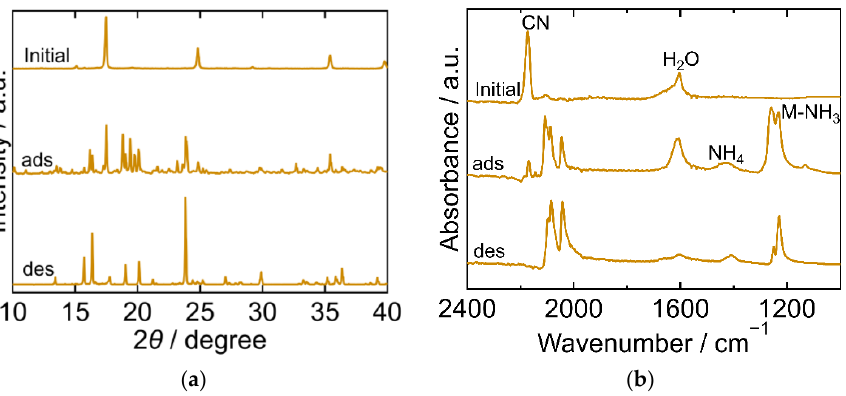
Figure 2. XRD patterns ( a ) and FTIR spectra ( b ) of copper hexacyanoferrate (CuHCF). “Initial” sample is literally the sample before adsorption. The samples after adsorption and desorption are denoted by “ads” and “des”, respectively. The measurements were performed at ambient